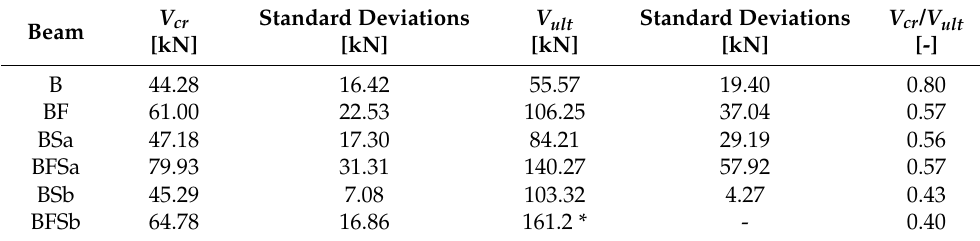
Table 4. The mean values of forces V cr and V ult for particular beam series.